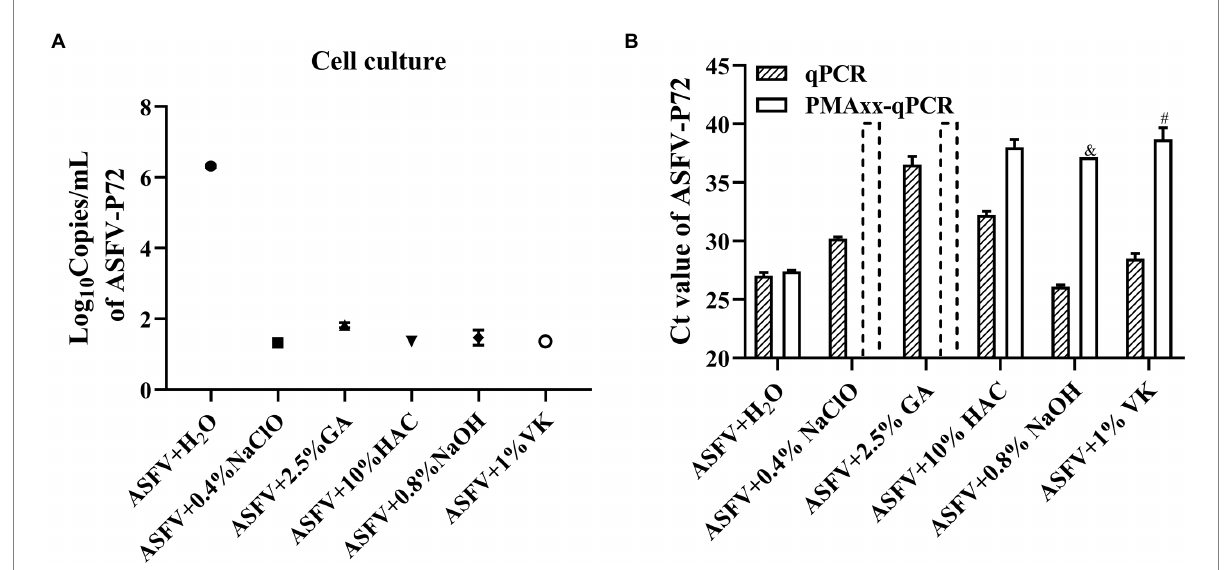
FIGURE 4 Evaluating the efficacy of the chemical disinfectants by cell culture (A) and the Triton X-100 assisted PMAxx-qPCR assay (B) . Data were shown as mean ± SD of three independent repeats. The dotted columns represent the assigned Ct value of the result of no DNA amplification after 40 cycles. &, represents two of three repeats with no amplification after 40 cycles. #, represents one of three repeats with no DNA amplification after 40